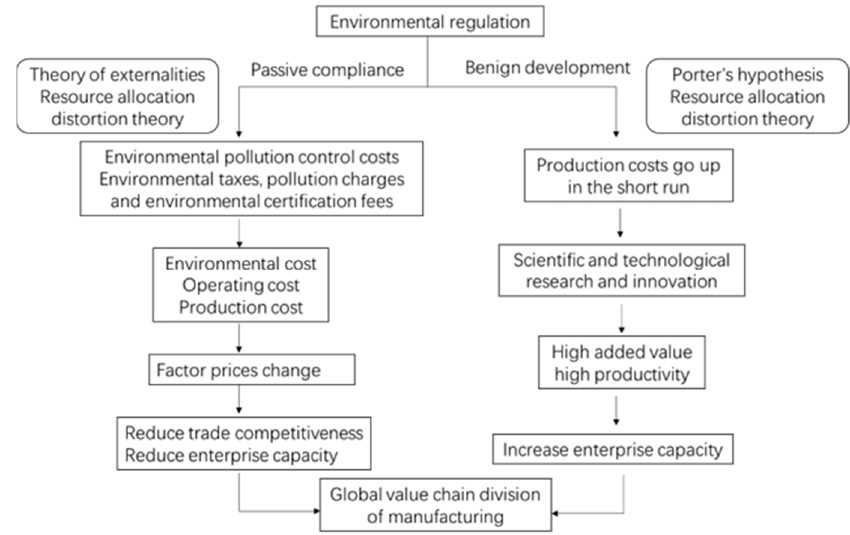
Figure 1. Theoretical mechanism diagram.